Question: Briefly state, in one sentence, what is plotted here.
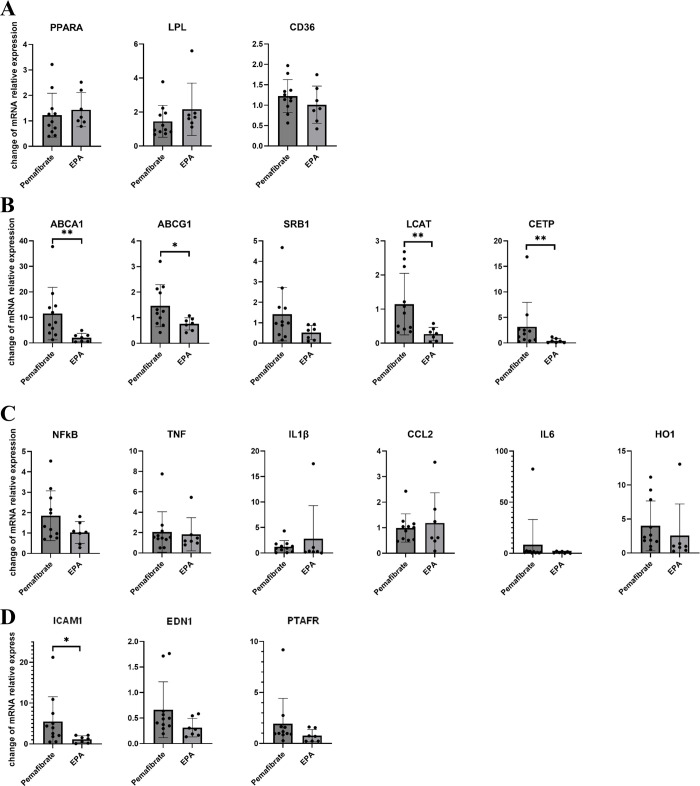
Answer: Between-group comparison of changes in PBMC gene expression after 16 weeks of treatment, categorized by gene function. (A) lipid metabolism-related genes (PPARA, LPL, and CD36); (B) cholesterol transport / reverse cholesterol transport-related genes (ABCA1, ABCGI, SCARBI, LCAT, and CETP); (C) inflammation/interferon / oxidative stress-related genes (NFKB1, TNFA, ILIB, CCL2, IL6, and HMOX1): (D) atherosclerosis / endothelial-related genes (ICAMI, EDNI, and PAFR). Changes in mRNA expression levels were compared between the pemafibrate and EPA groups in the PBMC subanalysis. Gene expression levels were normalized to HPRTI. PBMC, peripheral blood mononuclear cells; EPA, eicosapentaenoic acid. Data are presented as mean ± SD. *P < 0.05, **P < 0.01.